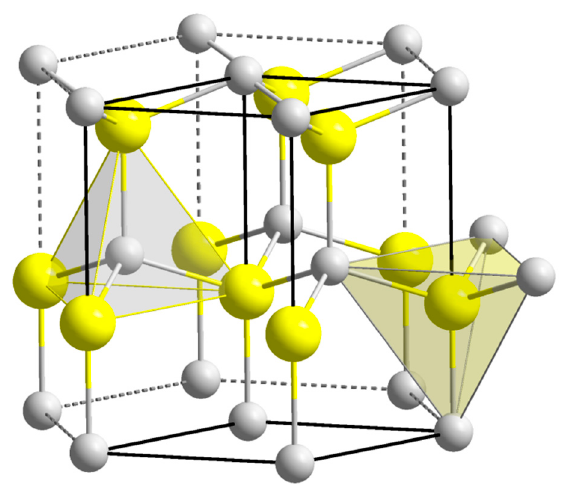
Figure 1. ZnO wurtzite cell, Zn in yellow, O in grey, the tetrahedral coordination is shown for both types of atoms. Source: [33], public domain.